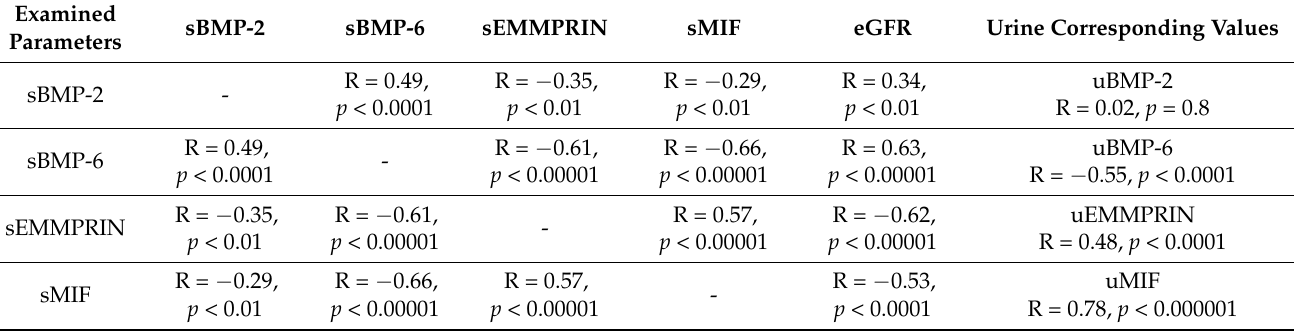
Table 5. Selected correlations between serum (s) and urine (u) parameters in children with CKD assessed by Spearman’s correlation coefficient